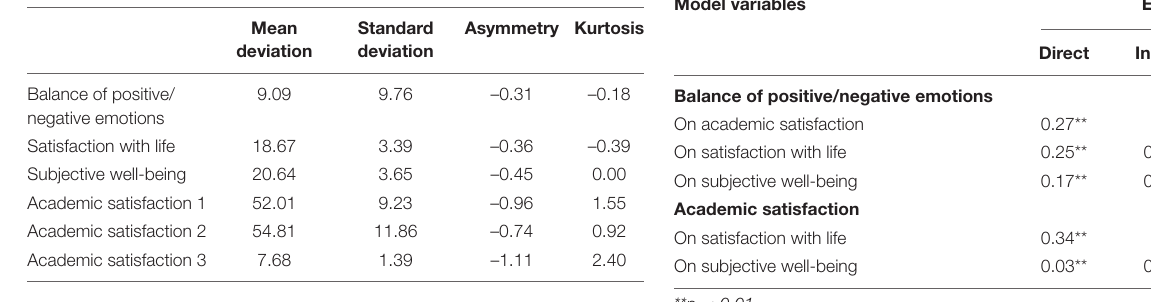
TABLE 1 | Descriptive statistics for mean and standard deviation, asymmetry and kurtosis of the variables comprising the subjective well-being model.